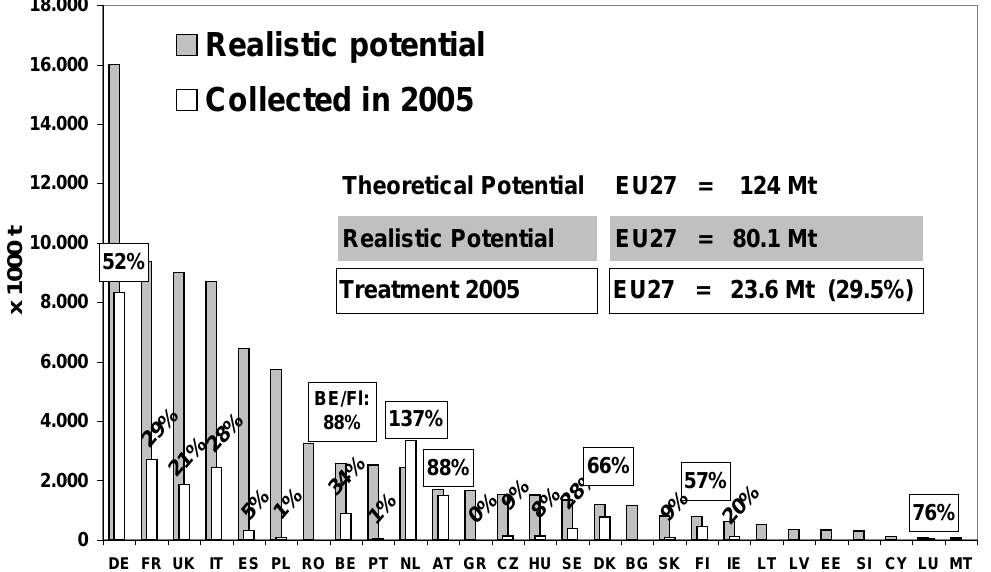
Figure 21: Collected and potential amount of source separated biowaste and green waste per year in